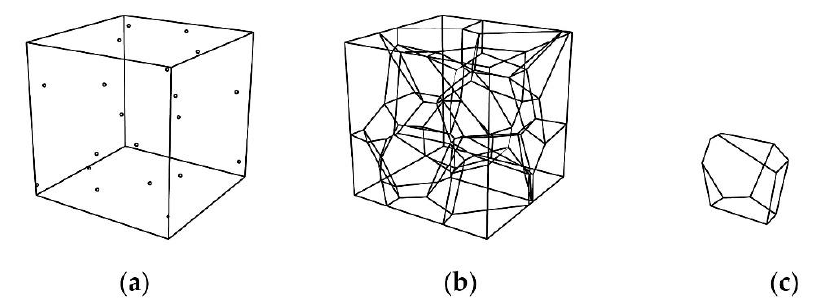
Figure 4. Formation of 3D Voronoi diagram: ( a ) bounding box with a finite set of points; ( b ) a 3D Voronoi diagram has formed as spheres expanded around each point until face boundaries are formed; ( c ) individual polyhedron cell.